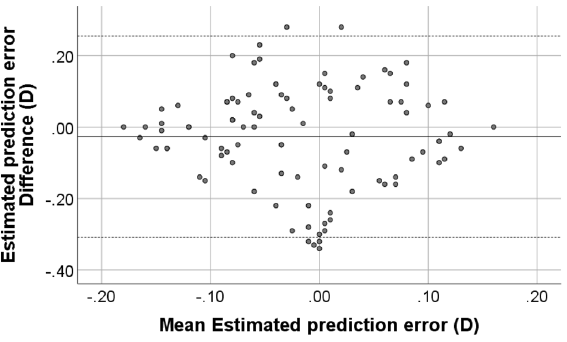
Figure 5. Bland–Altman plot of the prediction error using parameters from GALILEI G6 and ANTERION. The solid line represents the mean difference, while the dotted lines on each side show the upper and lower 95% LoA. The plot reveals that six eyes were out of the 95% LoAs. Created by SPSS (Version 22, SPSS Inc., IBM, Chicago,